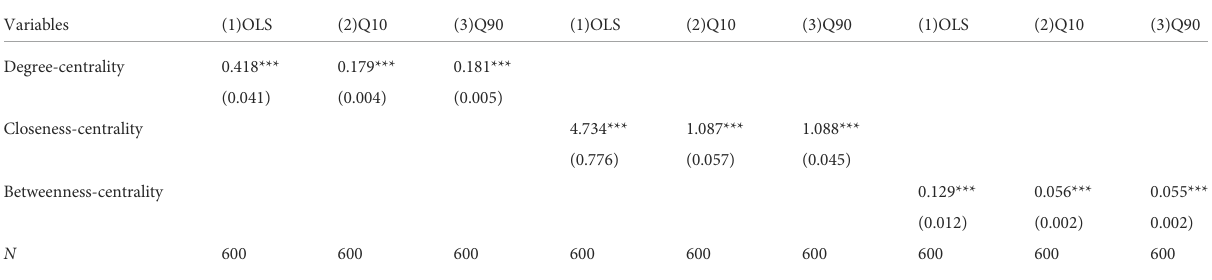
TABLE 7 Results for individual network structure